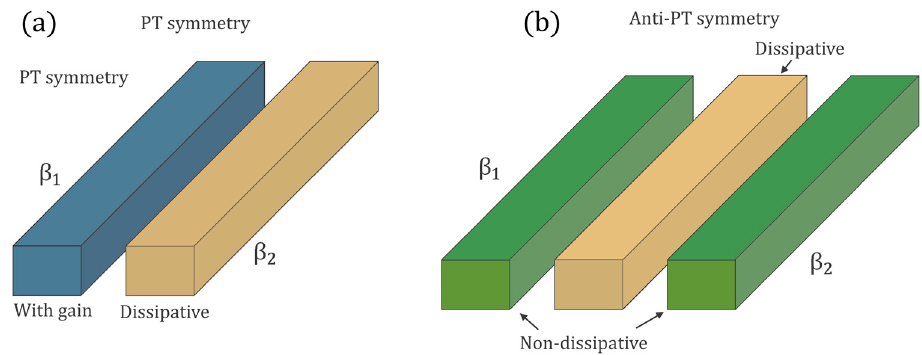
Figure 7. Coupled optical waveguides realizing PT-symmetric ( a ) and anti-PT-symmetric ( b ) Hamiltonians.